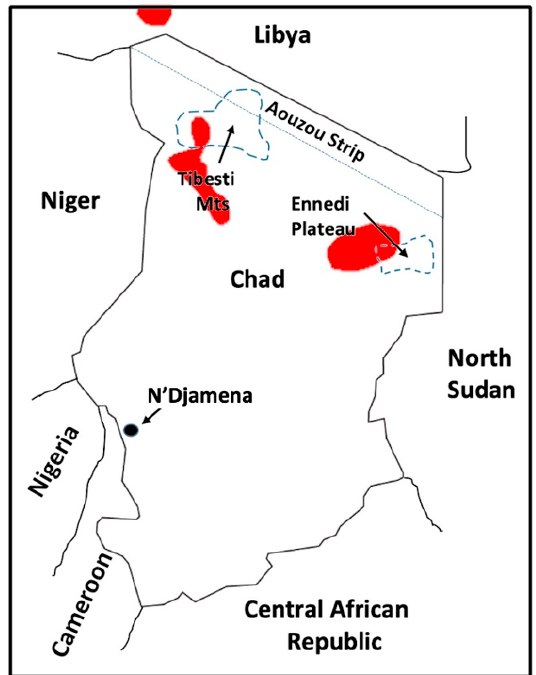
Figure 4. Locations and regions mentioned in the text in relation to desert locust activity and insecurity in Chad. Primary breeding areas in red.